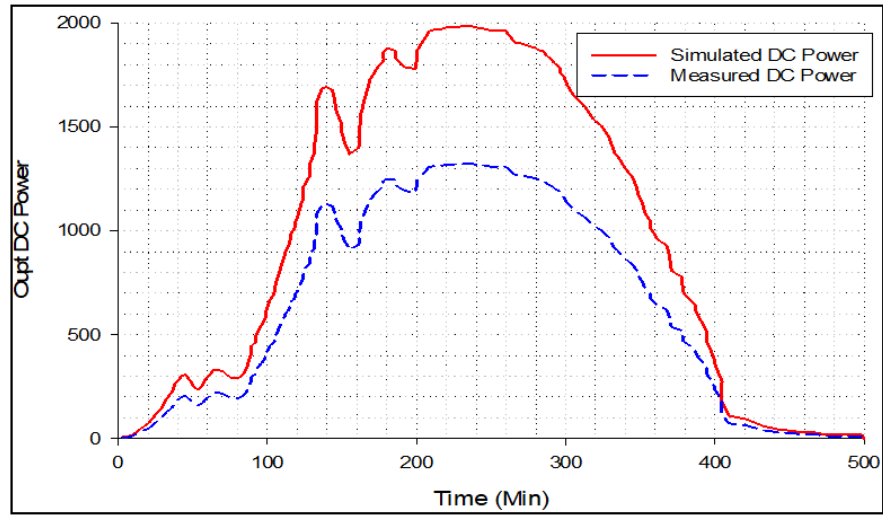
Figure 14. DC simulated power versus measured power (inverted bypass diode fault operation).